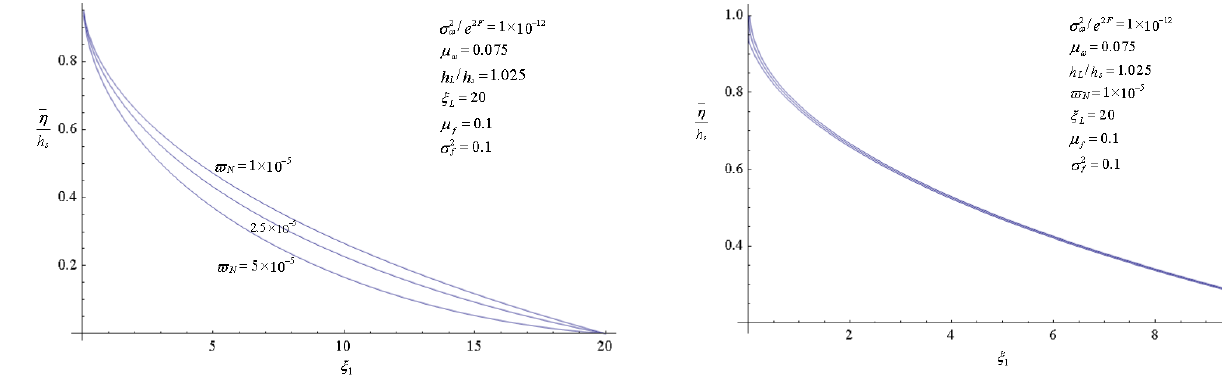
Fig. 4. Dimensionless mean elevation of seawater-freshwater inter- face and intervals of confidence ± 2 σ η